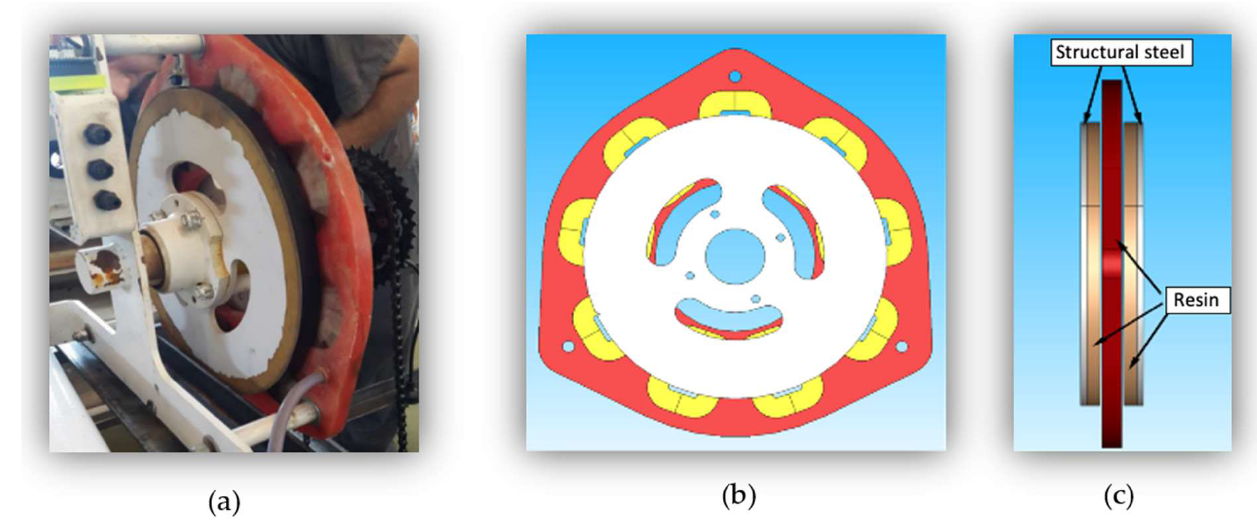
Figure 7. PMSG axial flux double rotor: ( a ) prototype, ( b ) 3D model front, and ( c ) 3D model lateral.